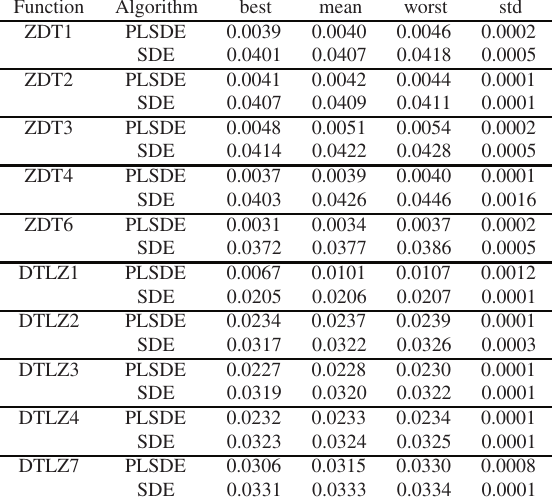
Table 1. IGD metric values of the solutions obtained by PLSDE and standard DE with original ε -dominance Function Algorithm